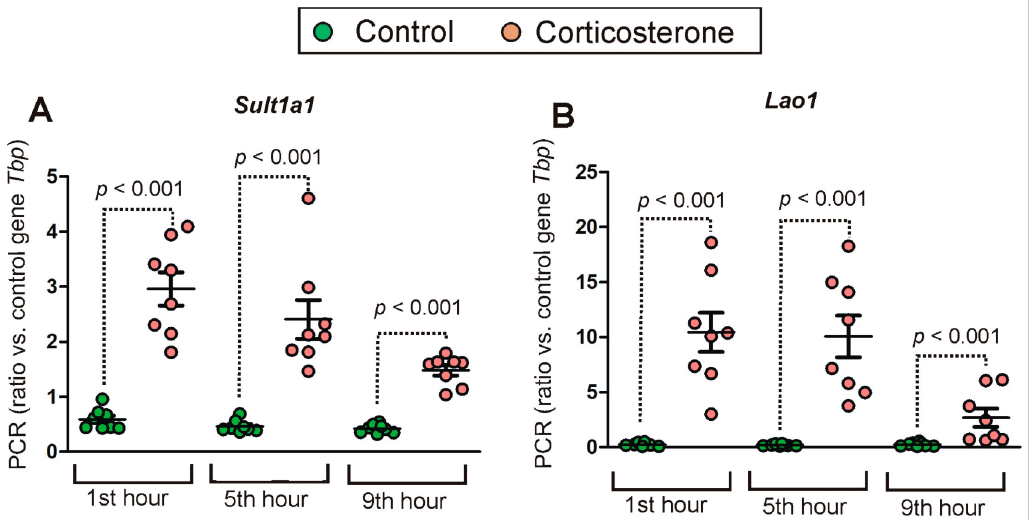
Figure 3. Expression pattern of Sult1a1 ( A ) and Lao1 ( B ) revealed by PCR. Data are presented as mean ± SEM overlayed on scatter plot of individual values. p values were determined based on Mann–Whitney U